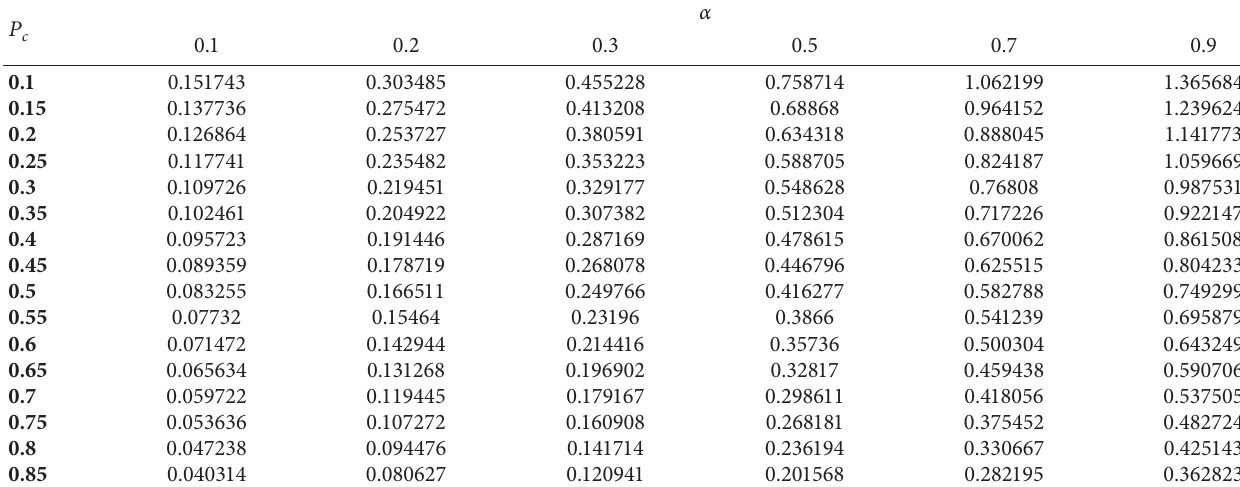
Table 1: Censoring times C .